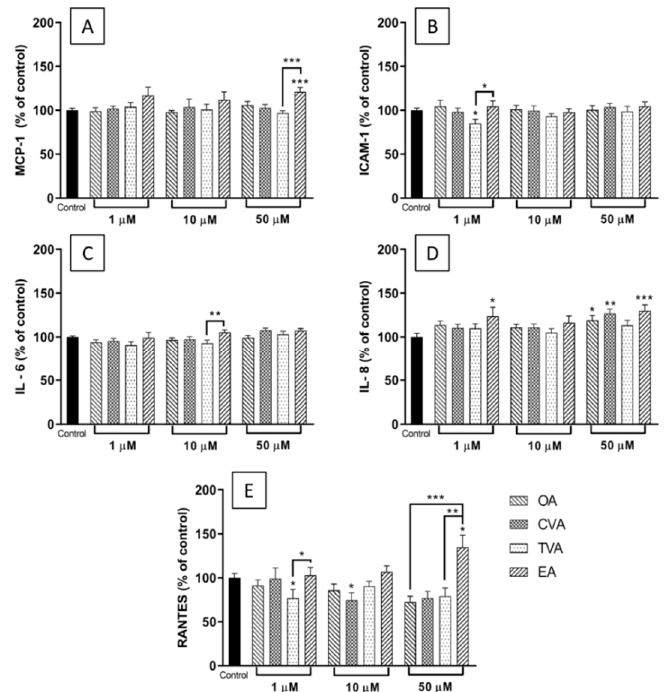
Figure 3. Concentrations (% of control) of MCP-1 ( A ), ICAM-1 ( B ), IL-6 ( C ), IL-8 ( D ), and RANTES ( E ) in the medium of EA.hy926 cells preincubated for 48 h with DMEM containing 0.1% of ethanol (Control) or FA at 1, 20, or 50 μ M, followed by incubation with TNF- α (1 ng/mL) for 24 h. Bars are mean ± SEM of 9 samples from 3 experiments. Data were analysed using one-way ANOVA with Tukey’s post hoc test. * p < 0.05; ** p < 0.01; *** p < 0.001 between groups indicated by joined lines or vs. Control when there is no joined line. OA = oleic acid, CVA = cis vaccenic acid, TVA = trans vaccenic acid, EA = elaidic acid.